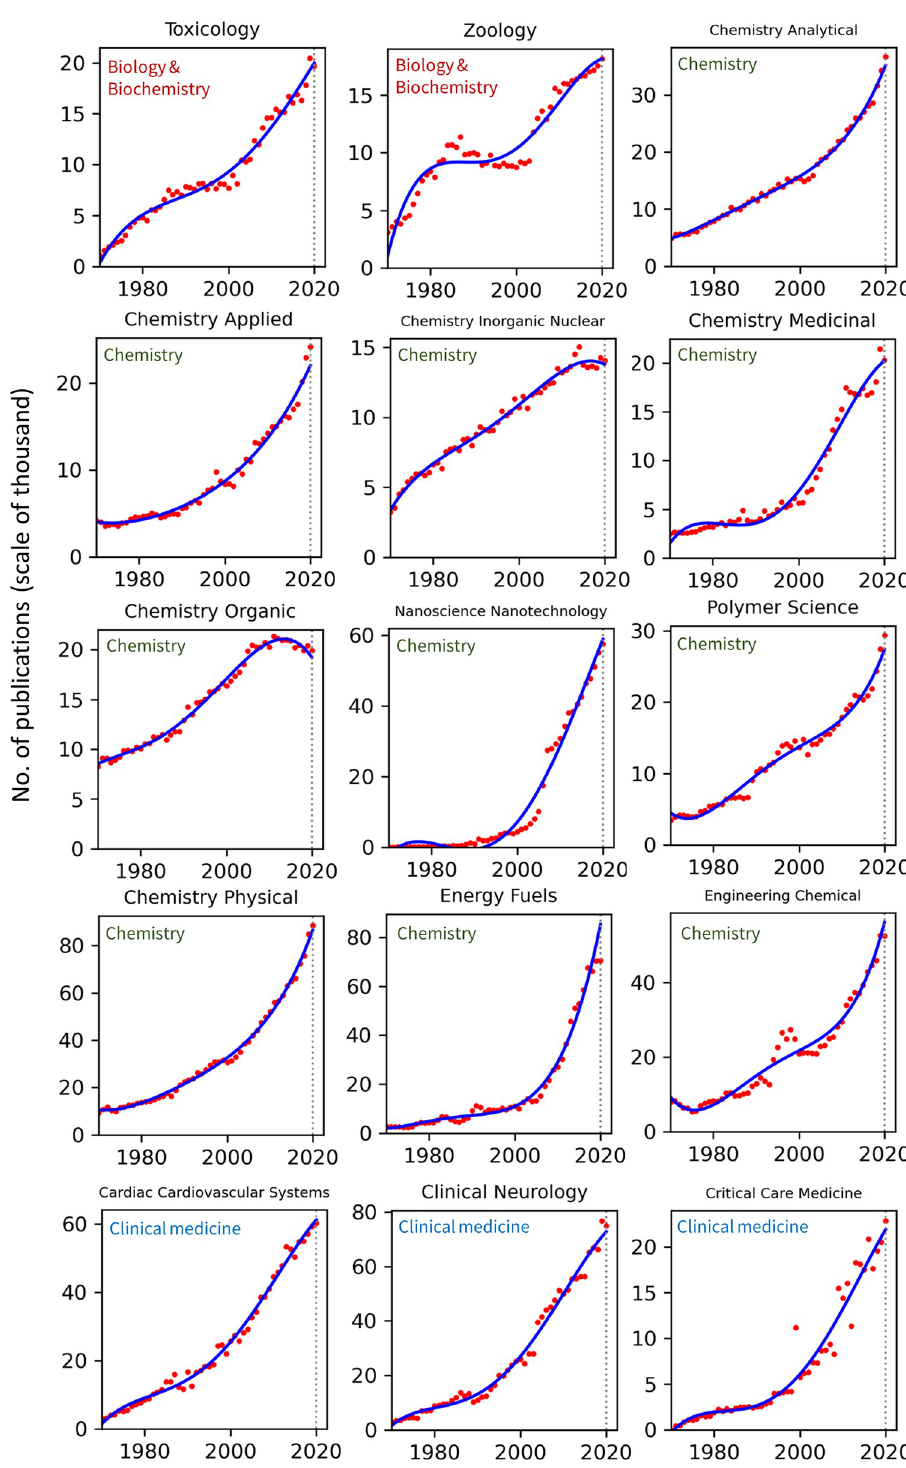
Fig 3. Temporal trends of research productivity in various scientific disciplines (part 2).